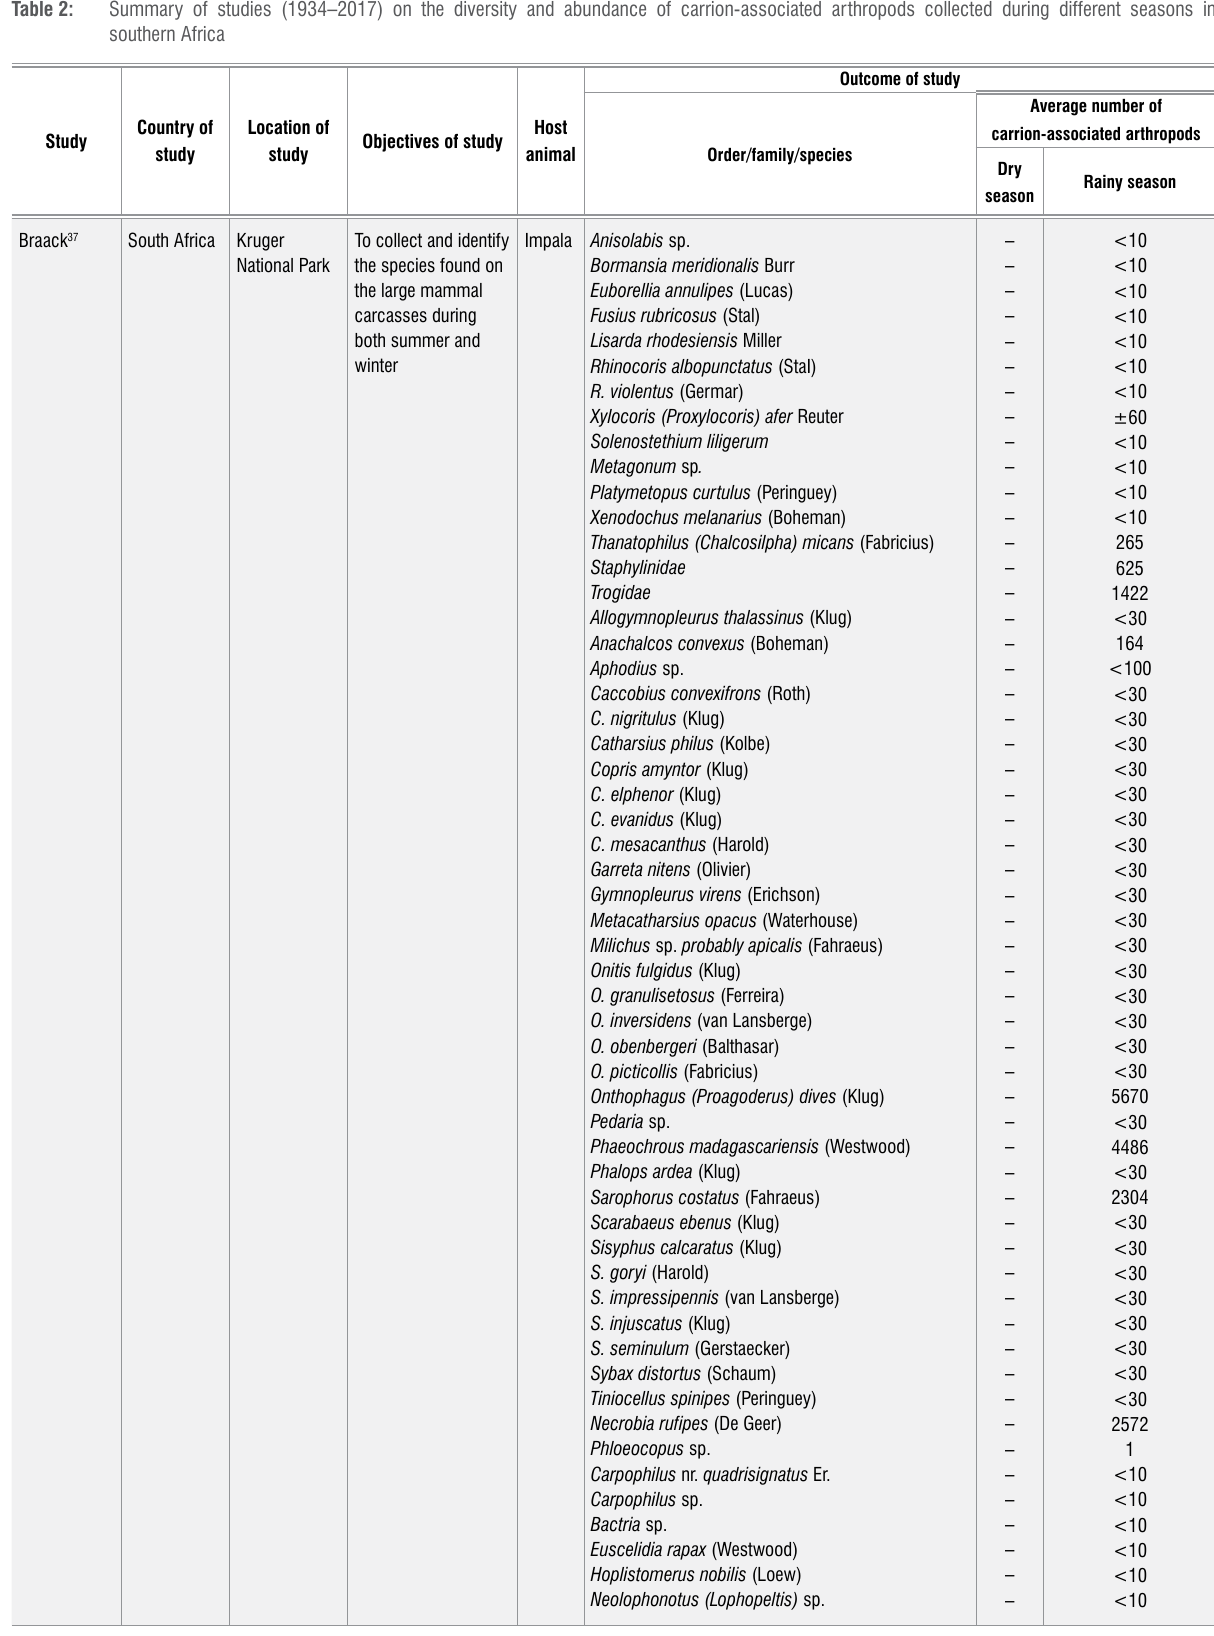
Table 2: Summary of studies (1934–2017) on the diversity and abundance of carrion-associated arthropods collected during different seasons in southern Africa